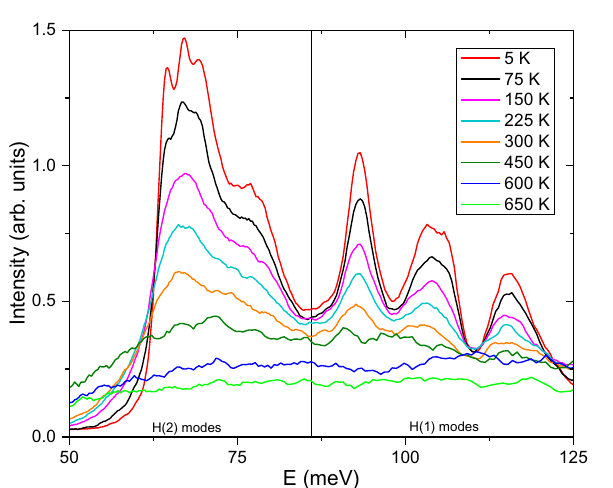
Figure 7. Crystal structure showing the tilt of the anionic polyhedra for the ( a ) orthorhombic and ( b ) hexagonal phases of BaD